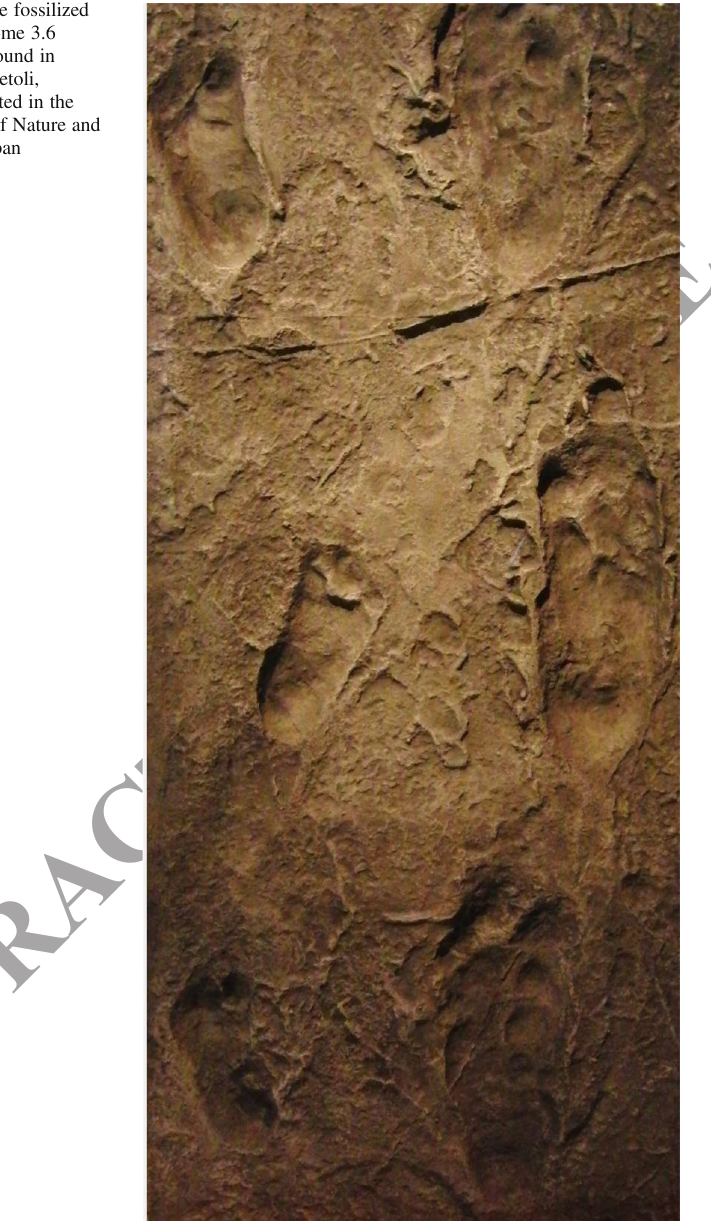
Fig. 2 Replica of the fossilized trail of footprints some